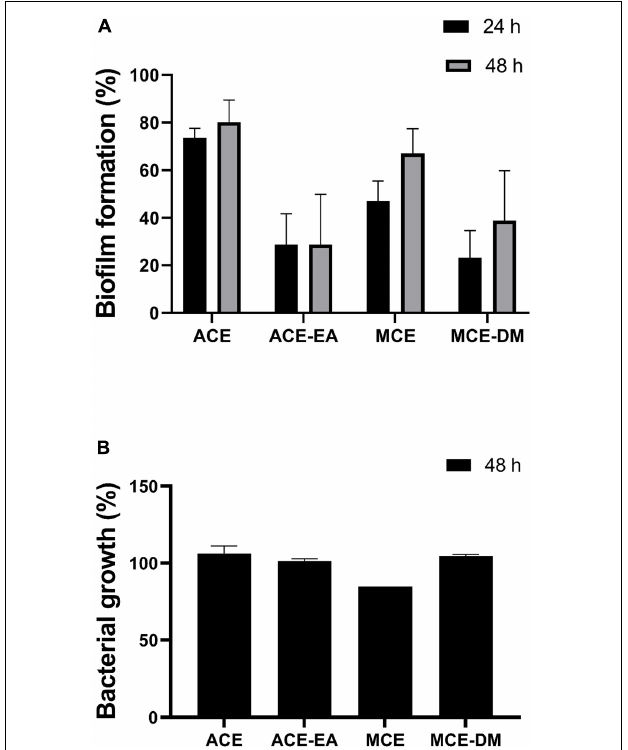
FIGURE 2 | Effect of different cell extracts of 7-day cultures of Bacillus licheniformis NCTC 10341 T on biofilm formation (A) and planktonic growth (B) of Pseudoalteromonas maricaloris . The effect of methanol cell extract (MCE), aqueous cell extract (ACE), and MCE extracted with dichloromethane (MCE-DM), and ACE extracted with ethyl acetate (ACE-EA) on biofilm formation was evaluated after 24 and 48 h with the xCELLigence real-time monitoring system. Planktonic growth was measured as optical density at 600 nm of homogenized cultures after 48 h. All extracts were assayed at 0.35 mg/ml. Values are shown as a percentage in comparison with untreated controls ( n =